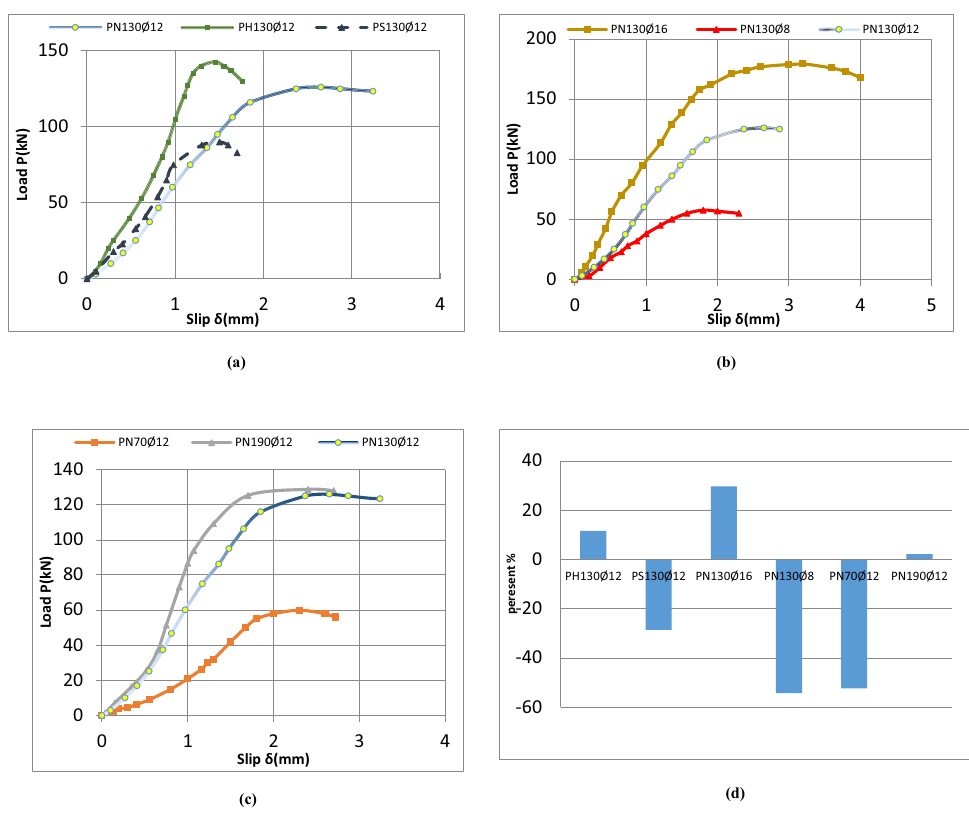
Figure 6: Load – slip curves of pushout for smooth surface specimens. ( a ) Alteration strength of new concrete, ( b ) alteration diameters of bolts, ( c ) alteration embedded length, and ( d ) percentage of di ff erences between of smooth surface specimens with reference model